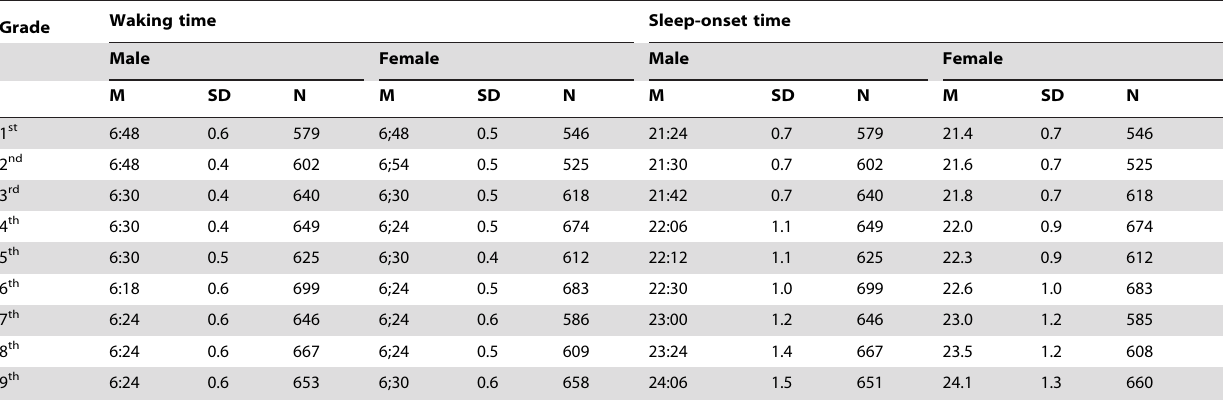
Table 2. Waking and sleep-onset times on weekdays.